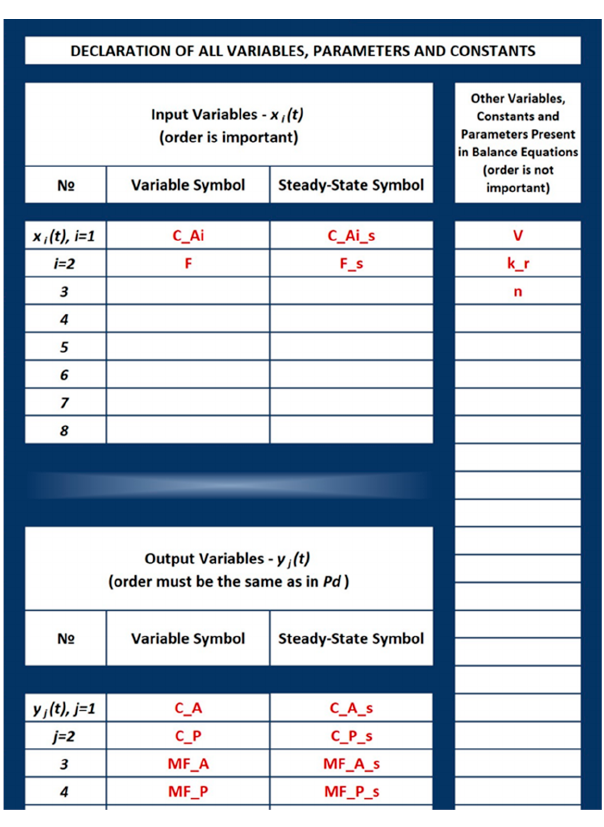
Figure 7. Variable declaration field in cNFR Main Window for Example 1: CSTR.